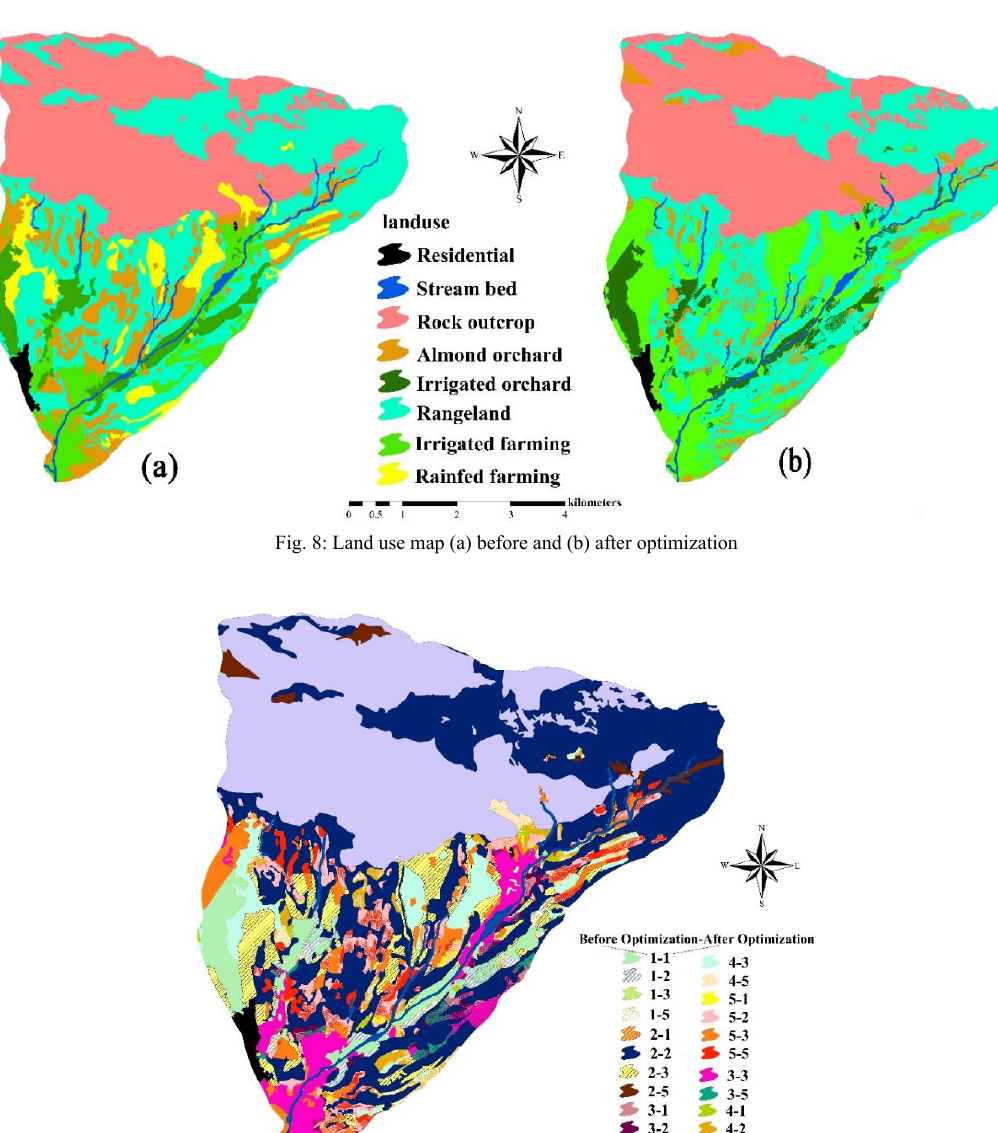
Fig. 9: The cross map, intersected by the land use maps before and after optimization